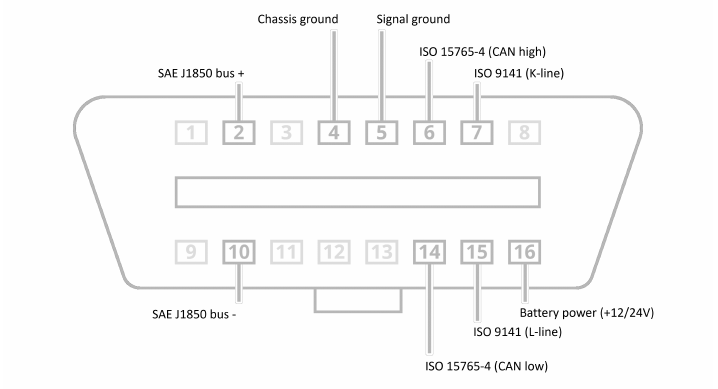
Figure 1. Pinout diagram for the standardized 16-pin J1962 OBD-II